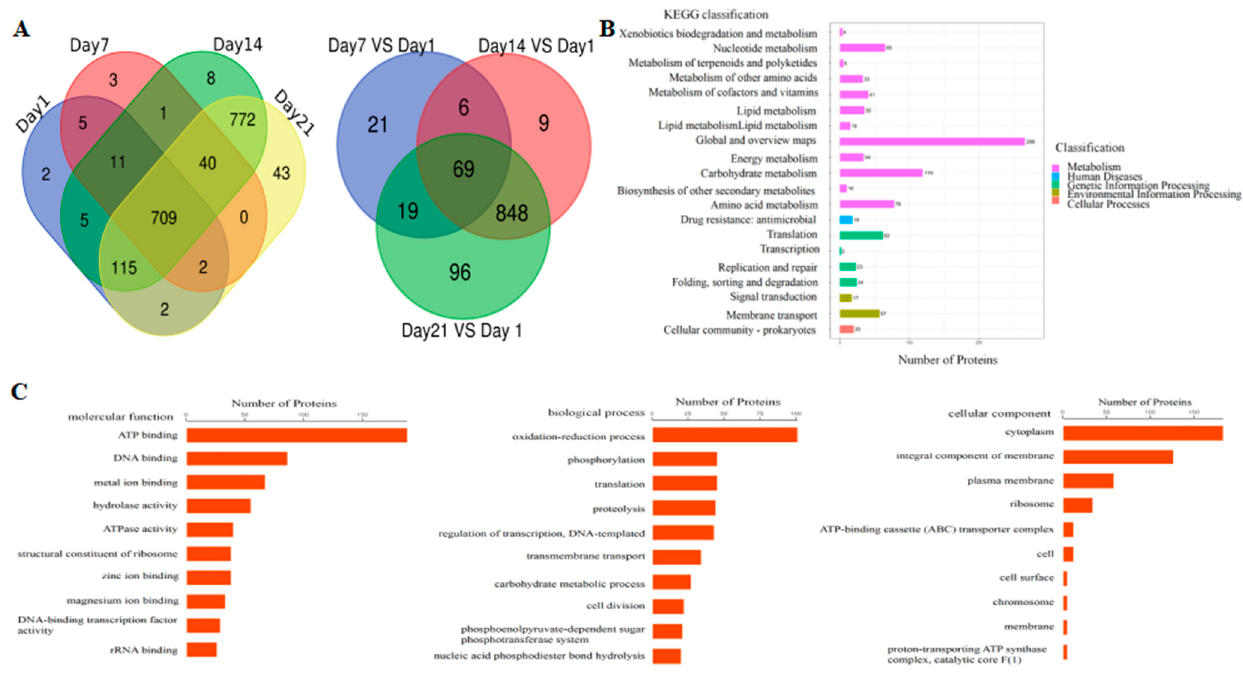
Figure 5. ( A ) The number of protein groups and differentially expressed proteins identified in Lpb. plantarum NMGL2 in fermented milk stored at low temperature (4 °C) for days 1, 7, 14, and 21. ( B ) KEGG pathway enrichment result of differ- entially expressed proteins. ( C ) GO terms enrichment result of differentially expressed proteins.